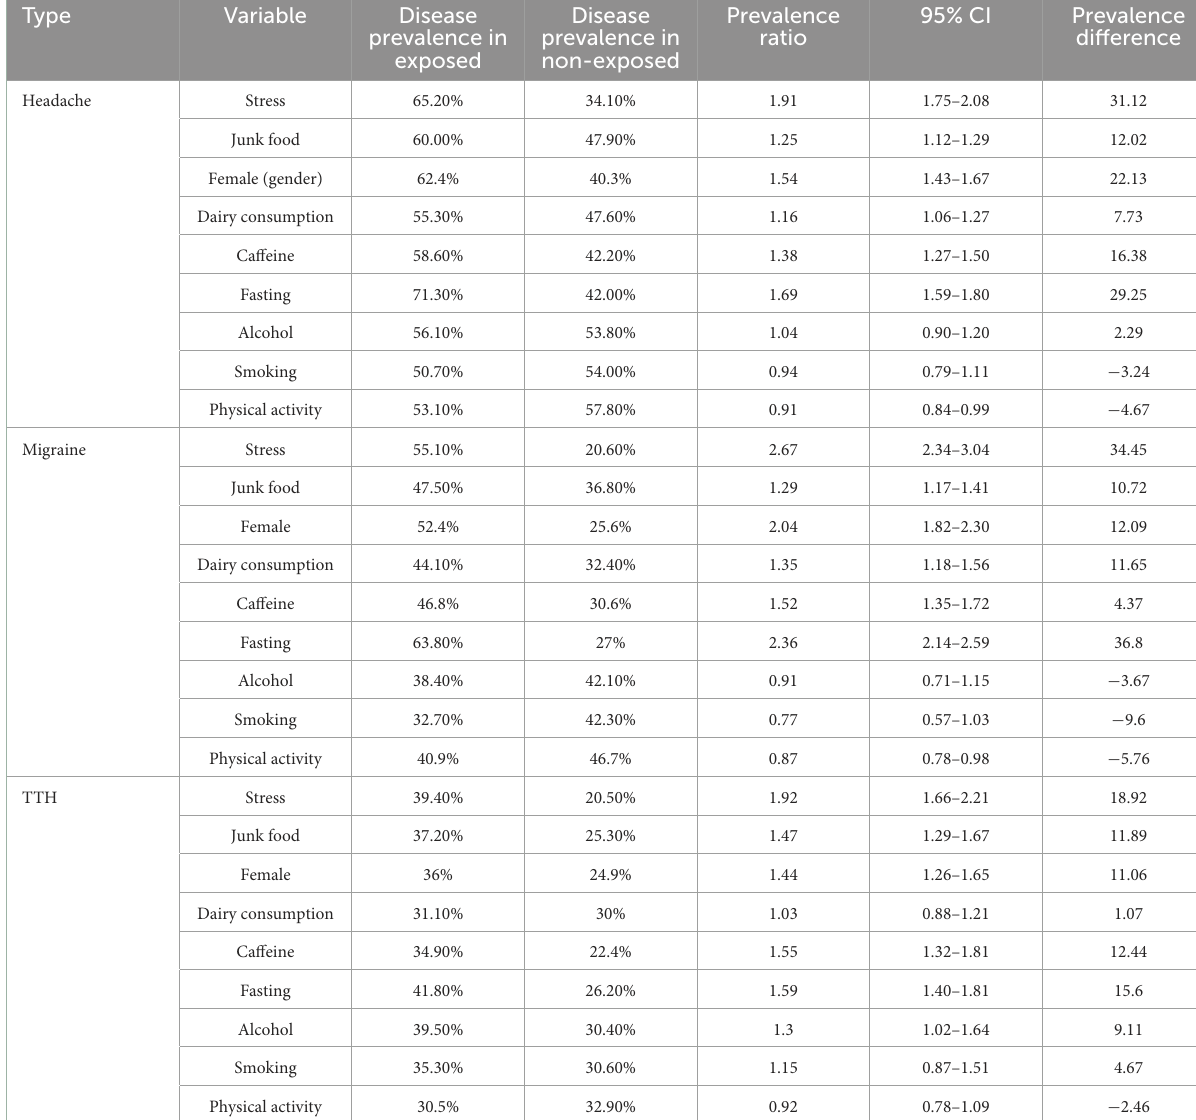
TABLE 7 Prevalence ratio of outcome under different lifestyle exposures/independent